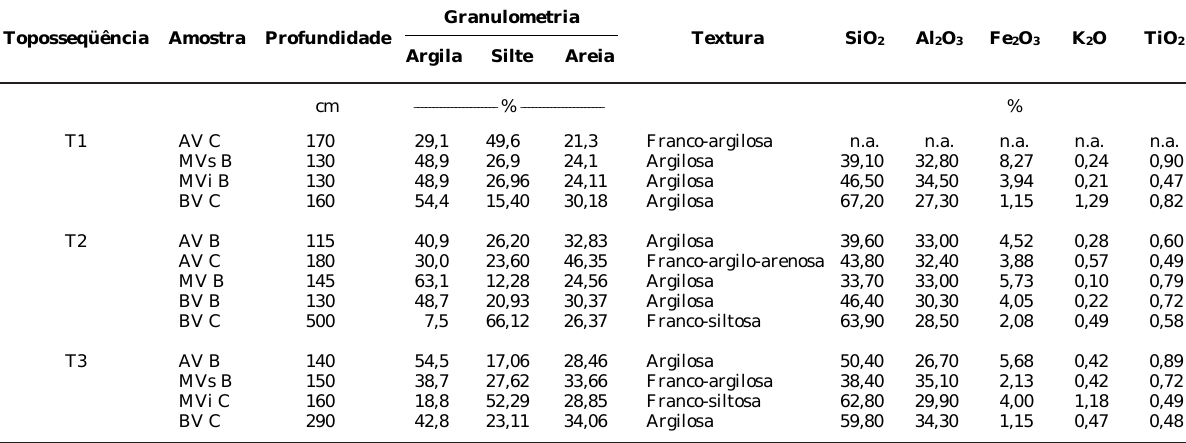
Quadro 3. Resultados granulométricos e químicos de materiais de horizontes selecionados das toposseqüências investigadas. T1 = toposseqüência 1; T2 = toposseqüência 2; T3 = toposseqüência 3